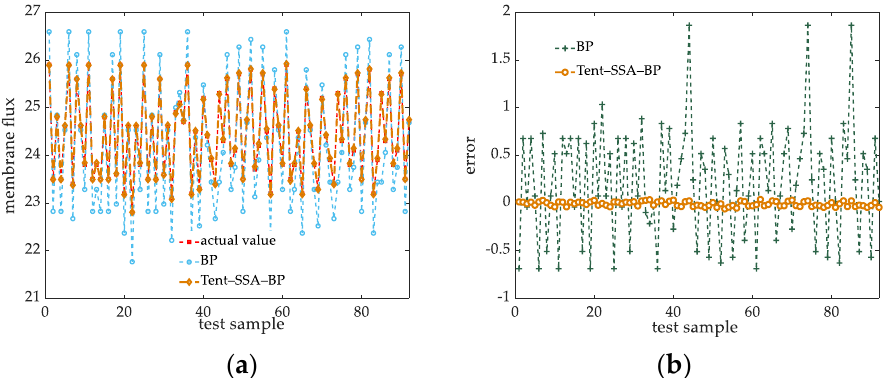
Figure 7. Optimizing algorithm to improve the comparison chart of prediction results. ( a ) Prediction contrast map. ( b ) Error comparison diagram.